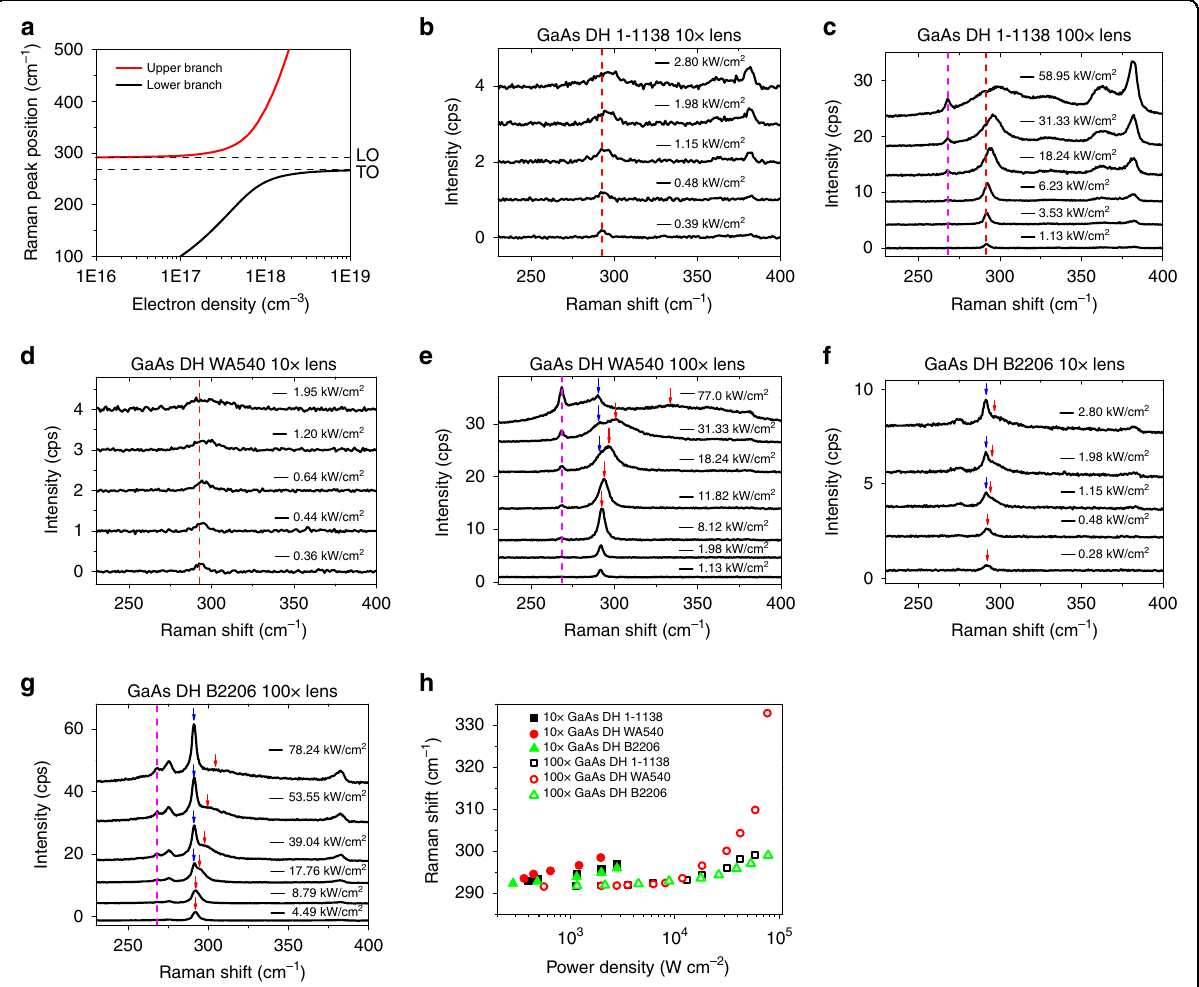
Fig. 1 Excitation power dependent Raman data. a Simulated curves for electron density-dependent LOPP coupled mode frequencies in GaAs. b , c Raman spectra of 1-1138 under 10× lens and 100× lens; d , e Raman spectra of WA540 under 10 × and 100× lens; f , g Raman spectra of B2206 under 10× lens and 100× lens. Red arrows and dashed lines are coupled LO mode; purple dashed line is TO mode; blue arrows point to LO mode from depletion layer. h Power-density dependent LOPP coupled mode frequencies for all GaAs samples under 10× and 100×